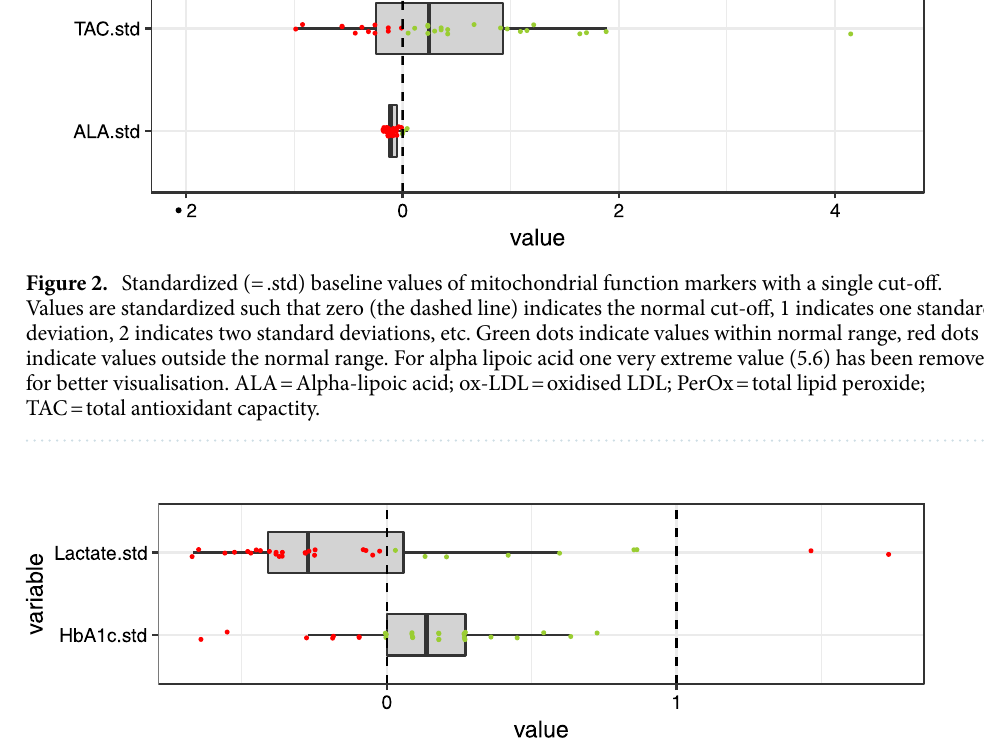
Figure 3. Standardized (= .std) baseline values of mitochondrial function markers with two cut-offs. Values are standardized such that zero (the dashed line) indicates the lower cut-off of the normal range and 1 indicates the upper cut-off of the normal range. Green dots indicate values within normal range, red dots indicate values outside the normal range. ALA = Alpha-lipoic acid; ox-LDL = oxidised LDL; PerOx = total lipid peroxide; TAC = total antioxidant